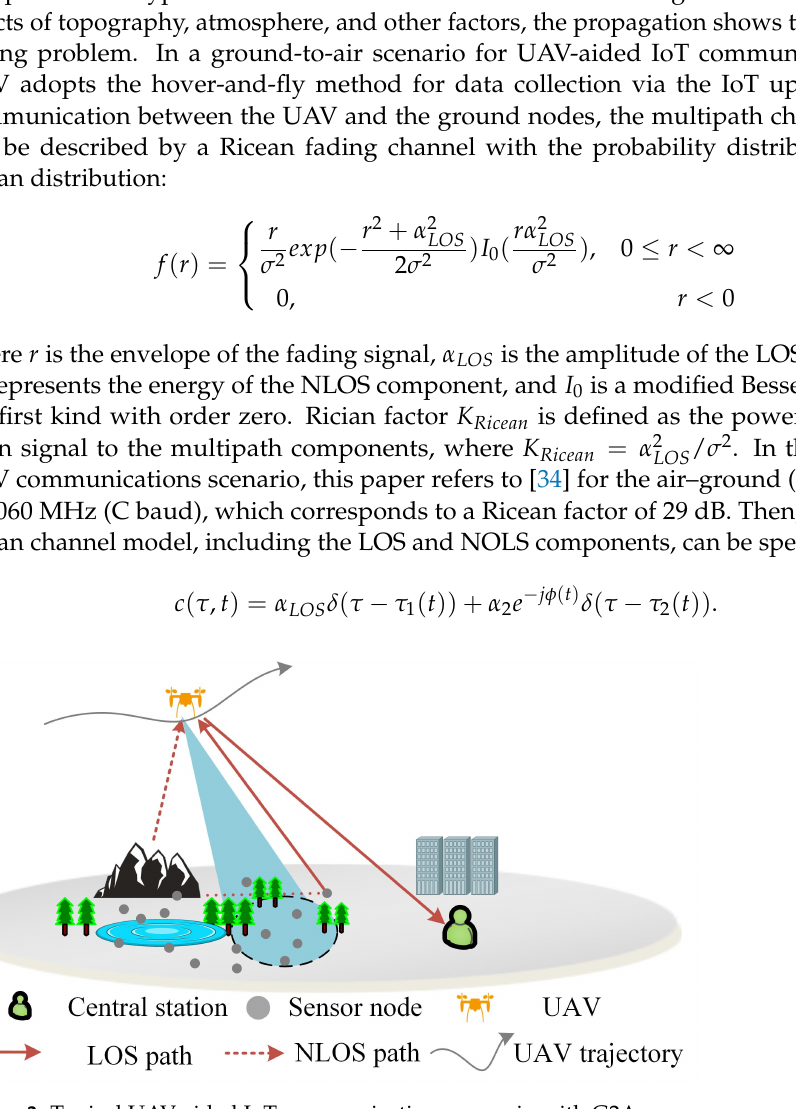
Figure 3. Typical UAV-aided IoT communications scenario with G2A